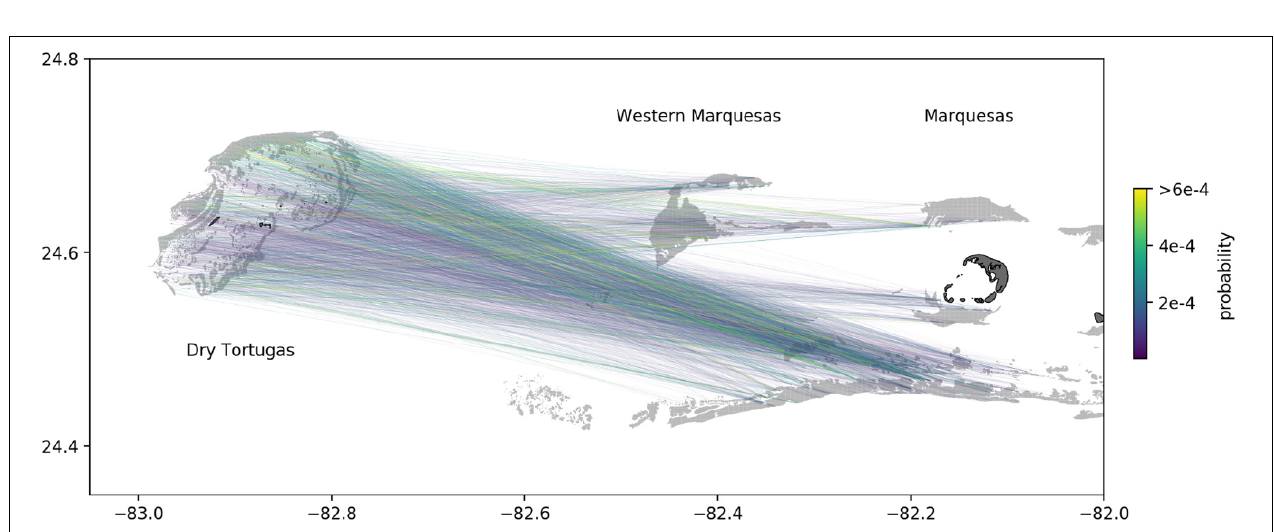
FIGURE 2 | (A) Monthly connectivity indicator between the Marquesas and the DRTO (blue), the Western Marquesas and the DRTO (orange) and the Marquesas and the Western Marquesas (green) between May 2018 and May 2021. Months during which Tortugas gyres were observed in the ocean model outputs are highlighted in gray. Milestones of the observed propagation of the SCTLD through the Marquesas are indicated by dark red dotted lines. (B) Monthly mean currents between the Marquesas and the DRTO between May 2018 and May 2021. Mean ocean circulation with an eastward component is highlighted by red arrows.